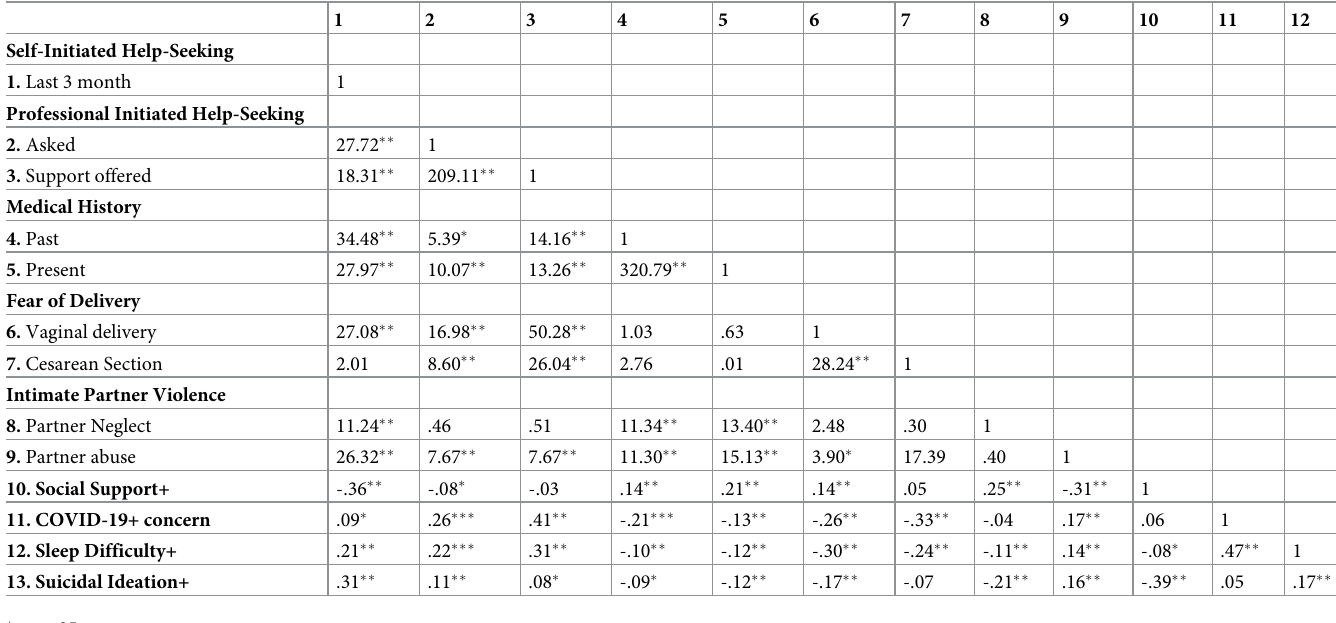
Table 3. Chi Square and point-biserial correlation interrelations results for study variables.